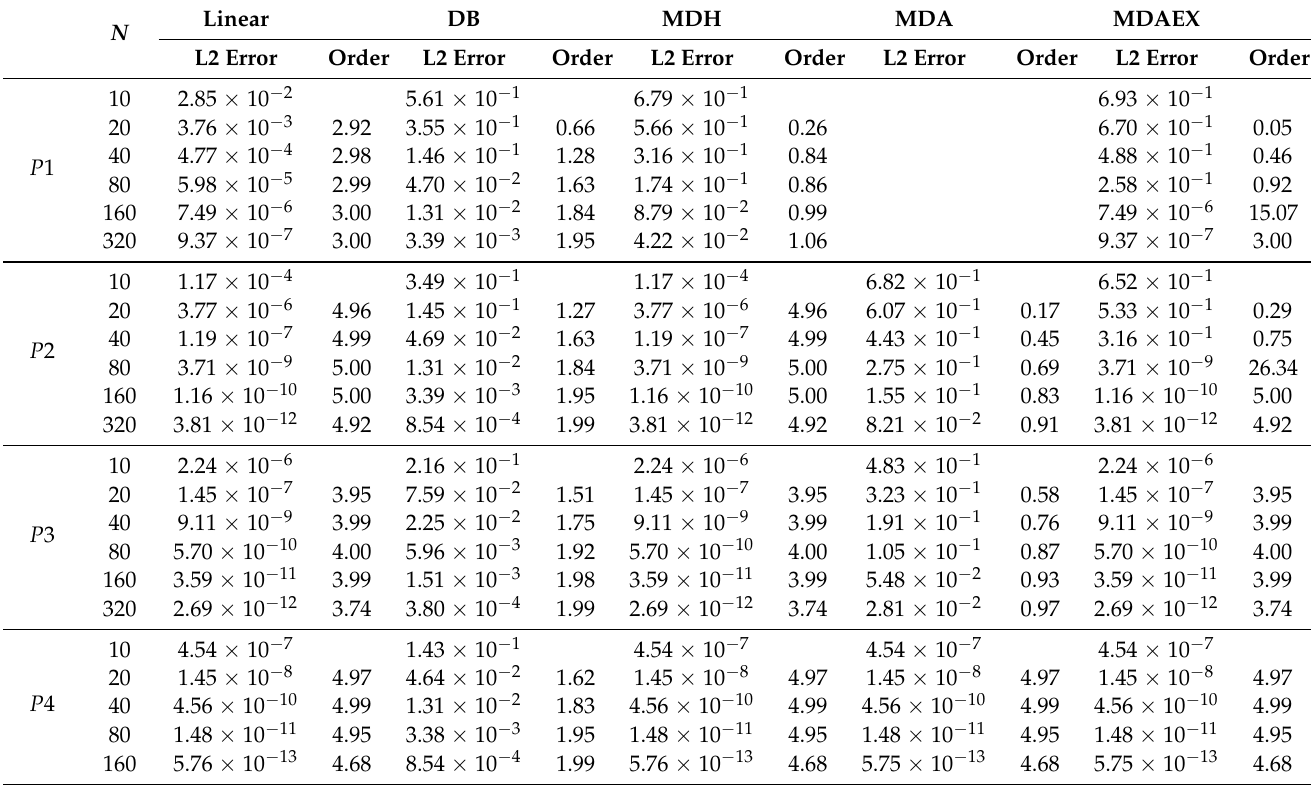
Table 1. L 2 errors and accuracy orders of shock-capturing models for the one-dimensional linear transport.